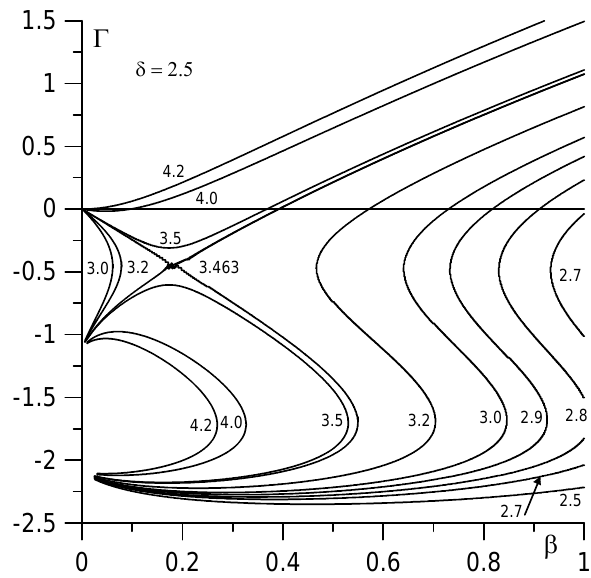
Fig. 5b. The same for δ = 1 (dawn/dusk).